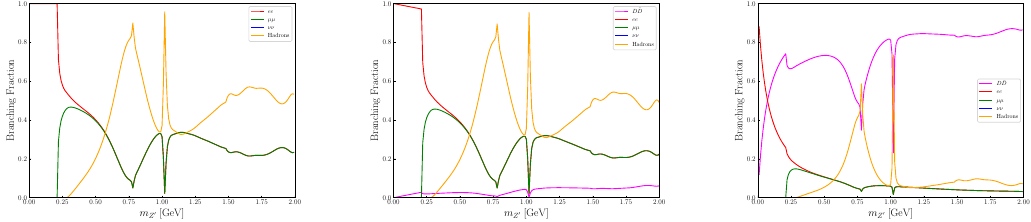
Figure 7 . Branching fractions of the Stueckelberg dark photon calculated using DarkCast . In the figure legends, νν represents the sum of all three generations of neutrinos, ‘Hadrons’ represents the sum of all the branching ratios of the hadronic channels. The left panel shows the branching fractions when there’s no dark decays while the middle and right panels show the case of dark decays for g X = 0 . 1 and g X = 1 . 0 , respectively. Since we take m D = m Z 0 / 4 , the hidden sector decays are present for any Z 0 mass. The analysis shows the strong effect of g X on the branching ratio in the hidden sector from minimal at g X = 0 . 1 to dominant at g X = 1 . 0